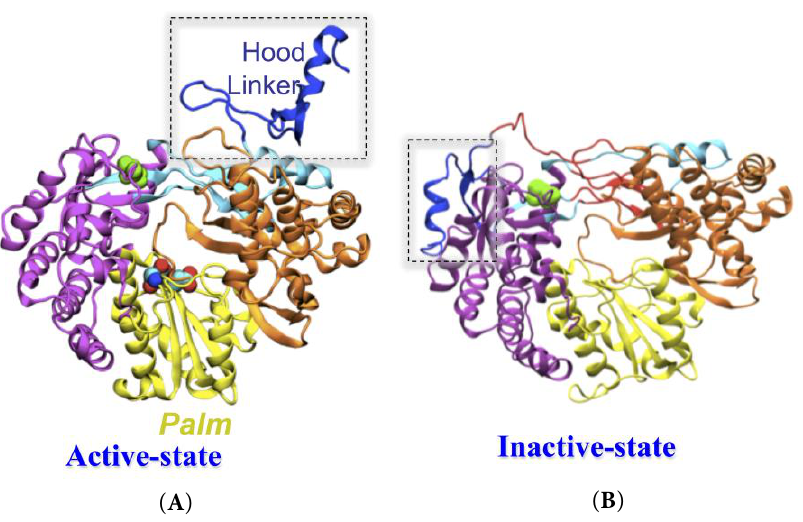
Figure 1. The architecture of BVDV-RdRp in ( A ) active and ( B ) inactive states, shows different conformations of hood and linker. Protein is rendered in new cartoon